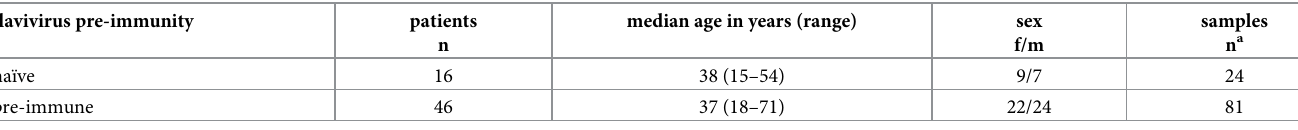
Table 3. Zika patients. flavivirus pre-immunity